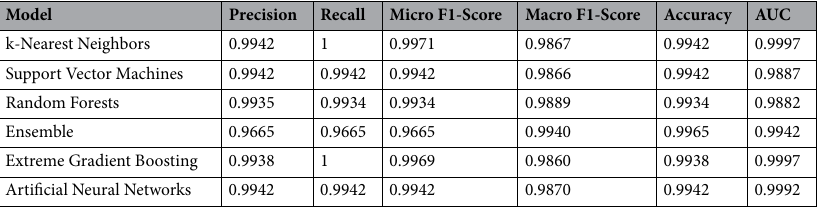
Table 2. DNA-type classification